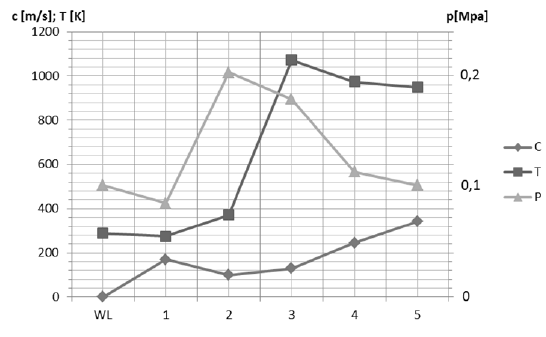
Fig. 3. Aerothermodynamic parameters in characteristic stations